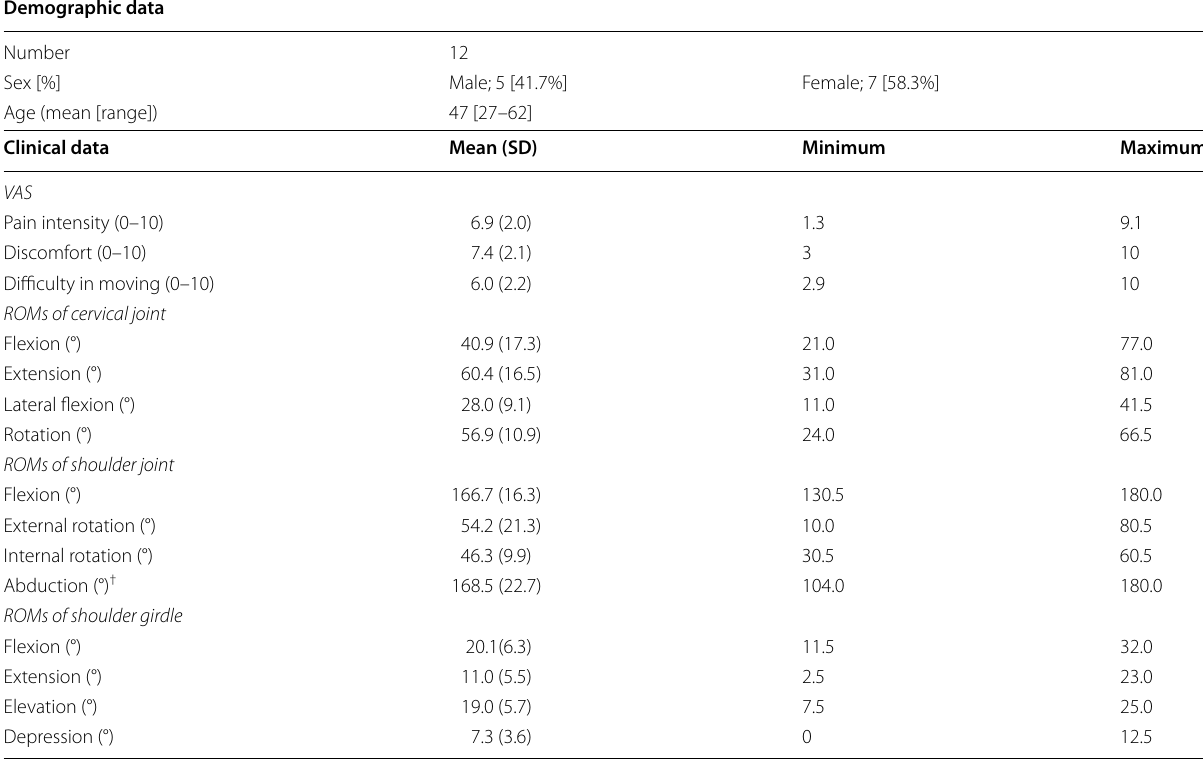
ROM range of motion, VAS = † Abduction datum of a participant is missing and the result of 11 participants is reported